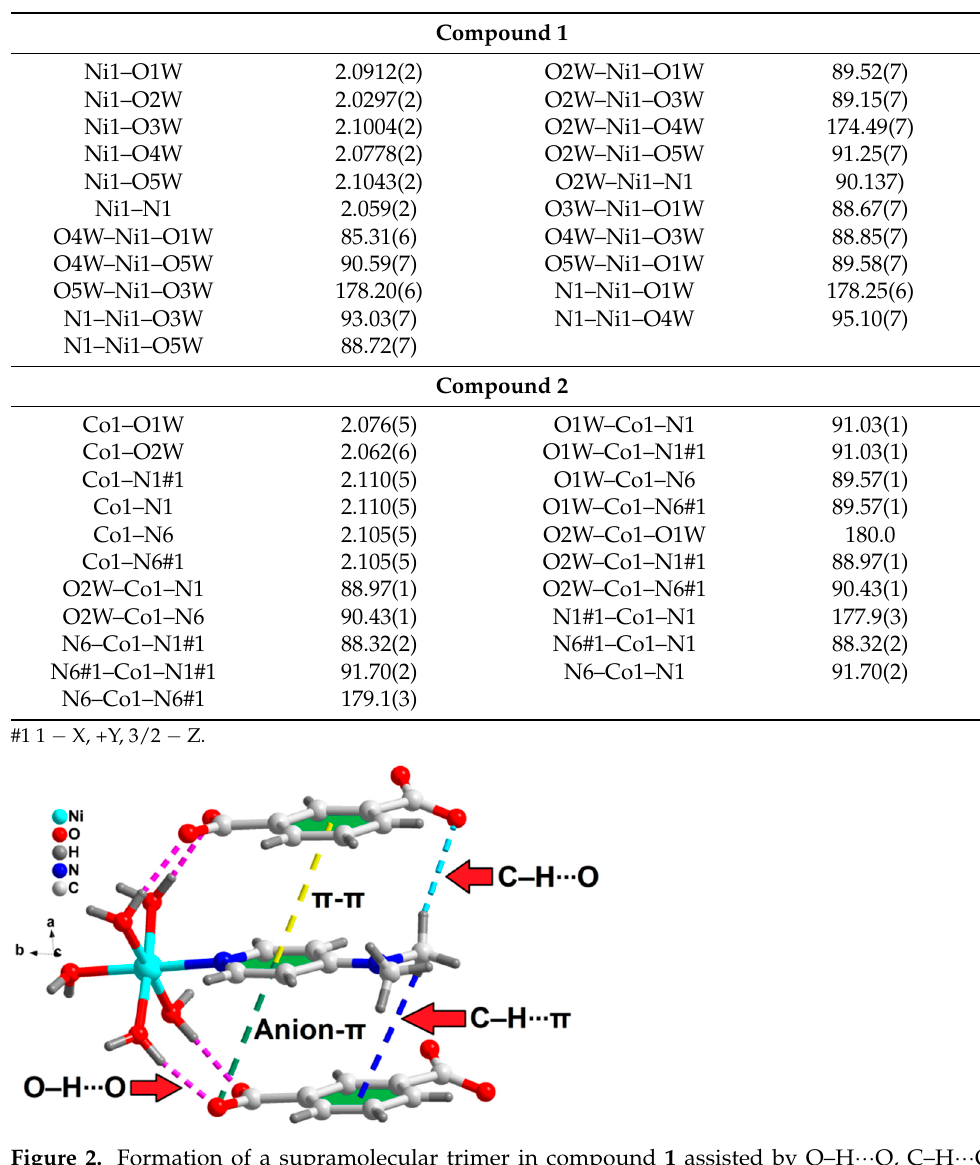
Table 2. Selected bond lengths (Å) and bond angles ( ◦ ) of Ni(II) and Co(II) centers in 1 and 2 , respectively.